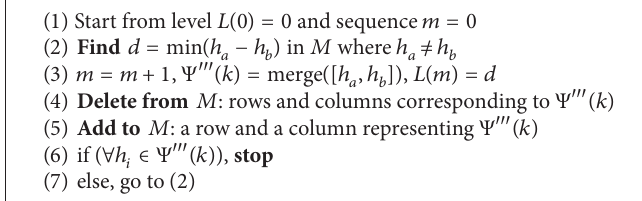
Algorithm 1: Disjoint cluster identification from heat MAP 𝑀 .